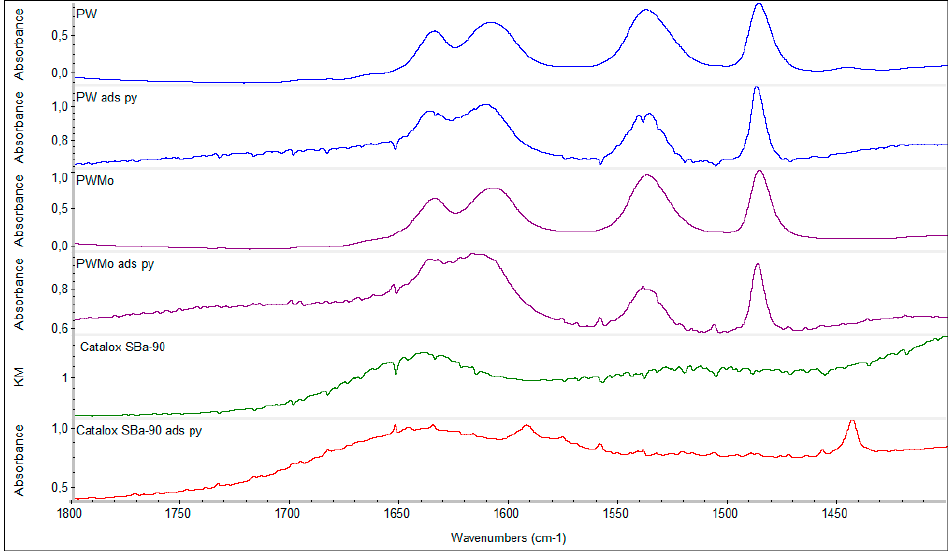
Figure 2. FT-IR spectra of pyridine adsorption (ads py ) on PW, PWMo, and Catalox SBa-90.